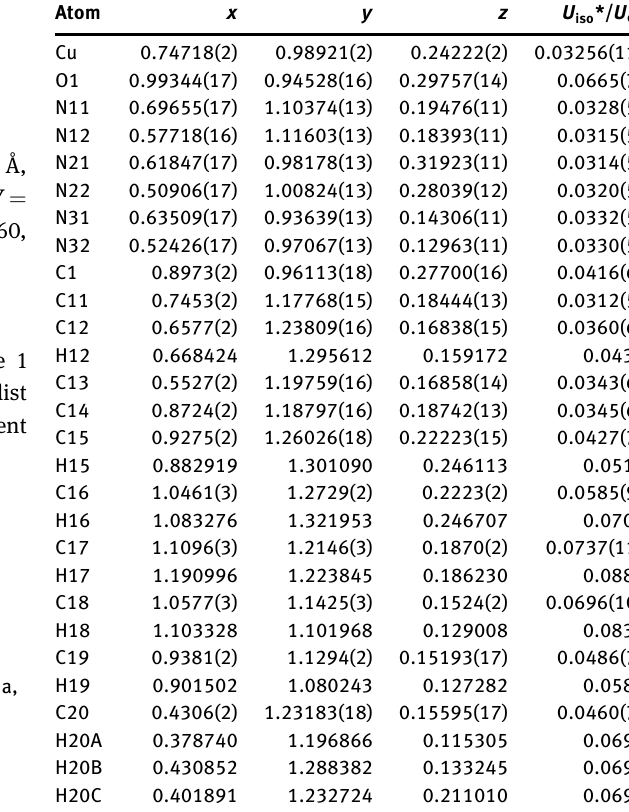
Table 2: Fractional atomic coordinates and isotropic or equivalent isotropic displacement parameters (Å 2